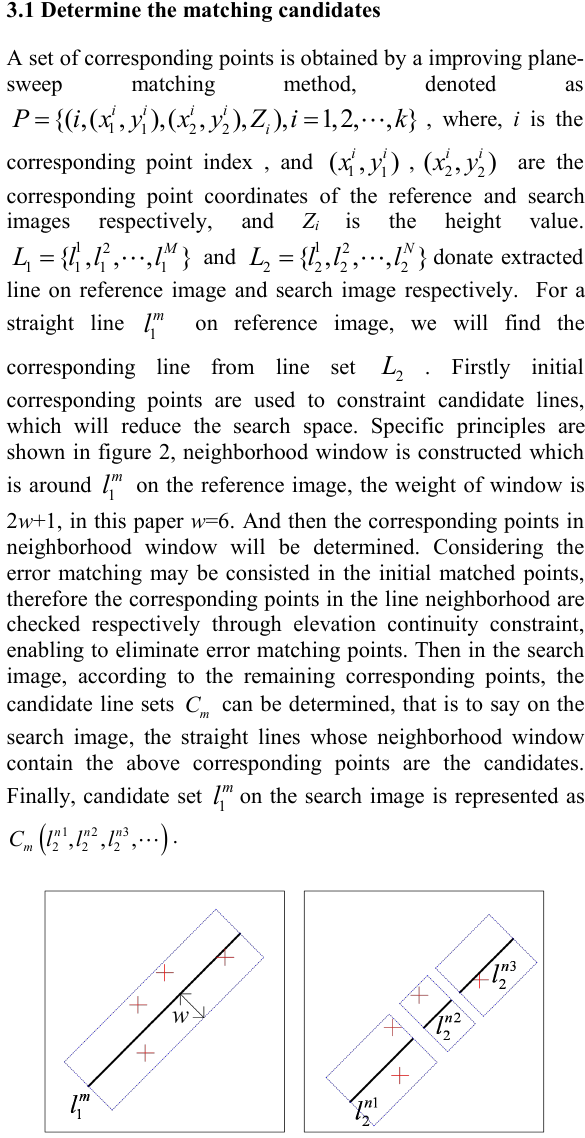
Fig.2 Neighborhoods of lines on the reference and